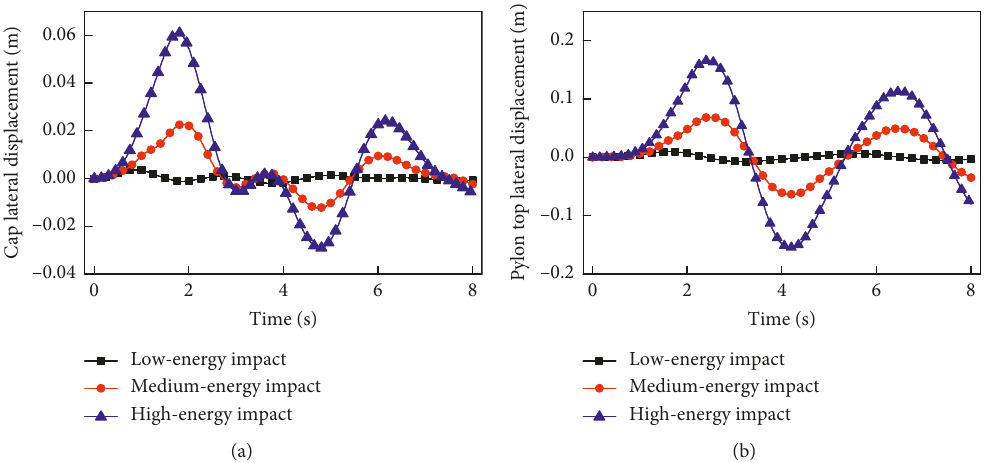
Figure 7: Bridge pylon lateral displacements under impact loads. (a) Cap lateral displacement. (b) Pylon top lateral displacement.